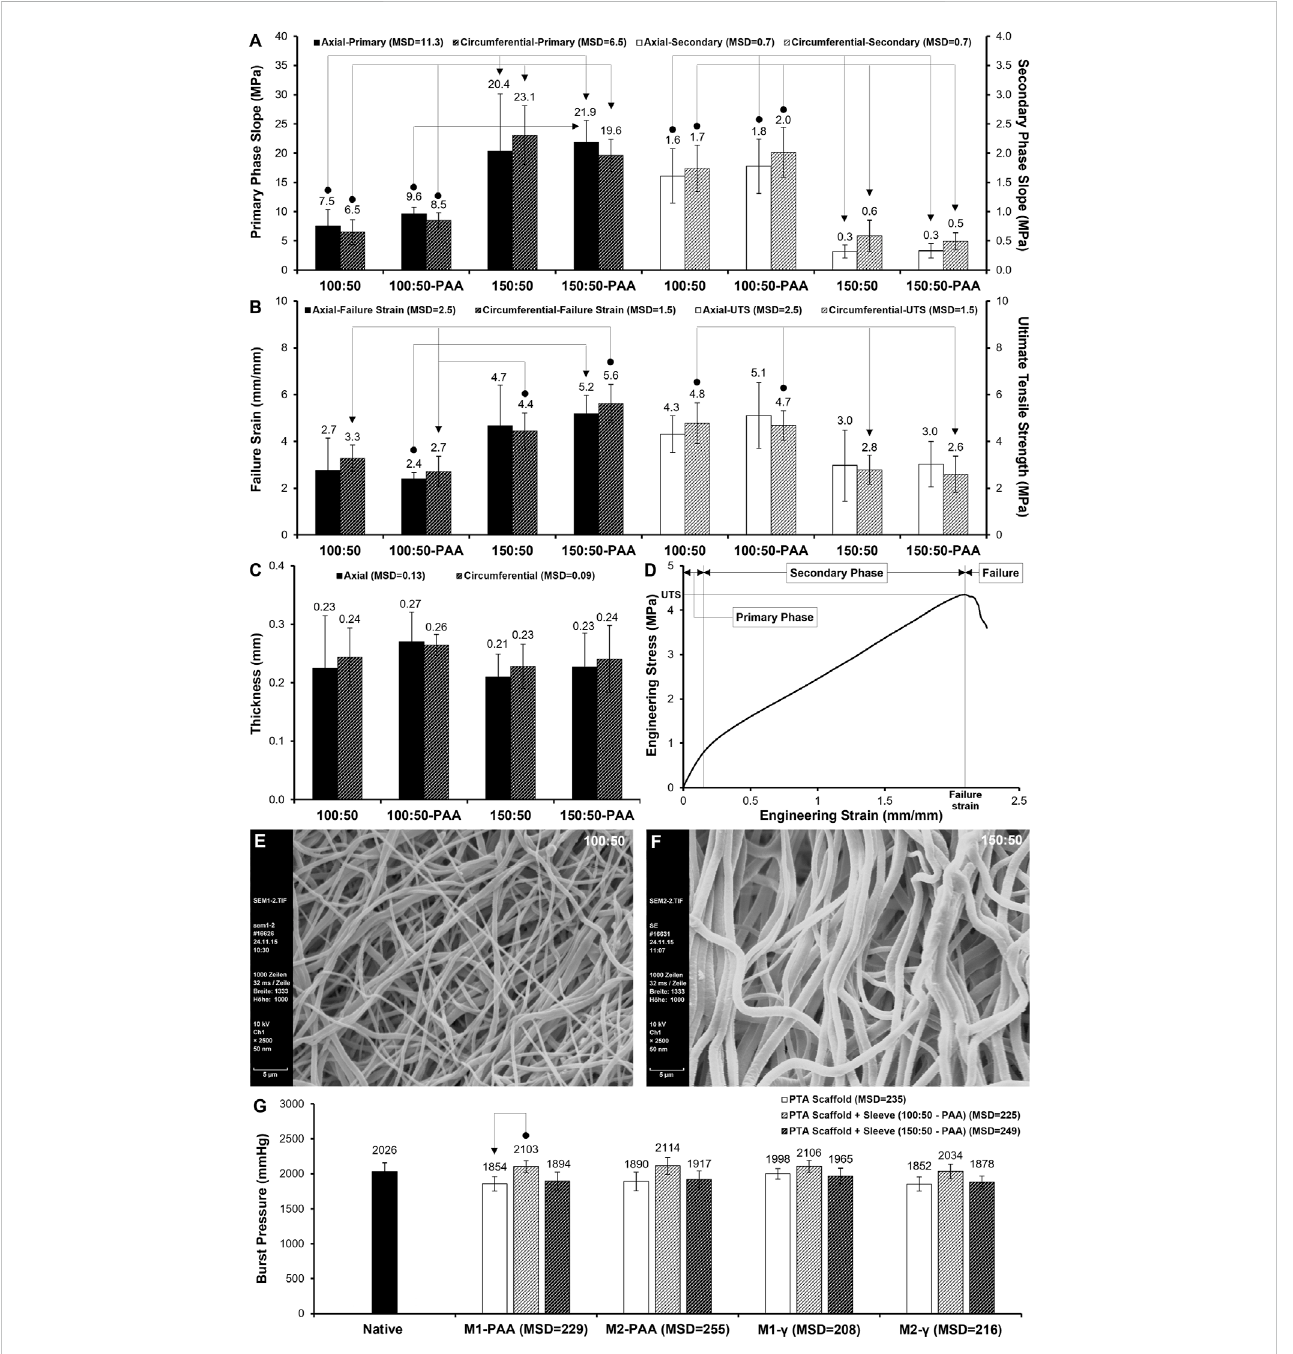
minimum signi fi cant difference. Connectors indicate signi fi cant difference between originator and end arrow group. (D) Sample stress-strain behavior of sleeve, showing primary, secondary and failure phases. (E,F) SEM of 100:50 (E) and 150:50 (F) sleeves (non-sterilized). Note the increased fi ber thickness and pore size of150:50blend. Scale bars indicate 5 μ m. (G) Burst pressureof PTA scaffoldstreated with (M2) or without (M1) RNase/DNaseand sterilized with eitherPAAor γ -irradiation,withandwithoutPAA-sterilized100:50and150:50polymericsleeves.Datashowsmeans( n